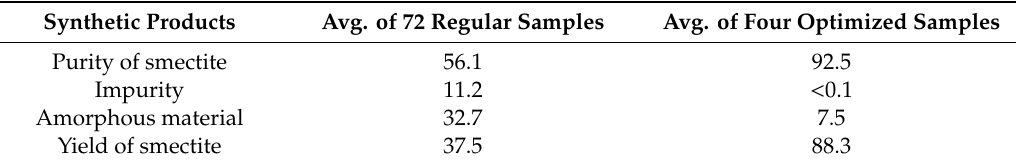
Table 8. Comparison of the AVGs of the purity and yield of 72 regular and four optimized synthesized smectite products (unit: